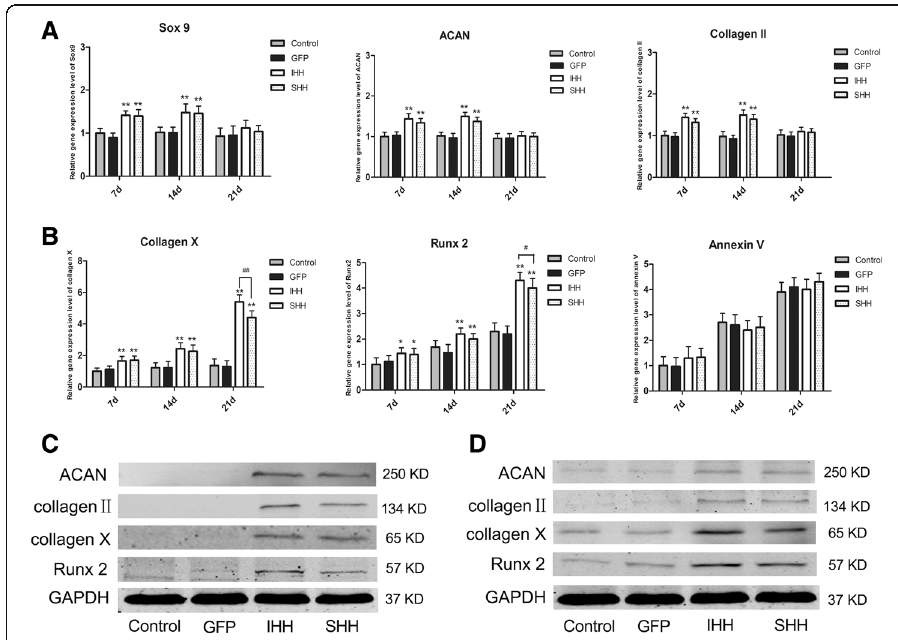
Fig. 3 Expression levels of related genes during differentiation induction in the 2D environment. ( a ) qRT- PCR analysis of Sox9, ACAN and collagen II on days 7, 14 and 21 during induction. ( b ) qRT-PCR analysis of collagen X, Runx2 and annexin V on days 7, 14 and 21 during induction. The results were normalized to B2M mRNA expression. Values are means ± SD (n = 3). ( c ) Expression of ACAN, collagen II, collagen X and Runx2 was detected by western blotting on day 10 during induction. ( d ) Expression of ACAN, collagen II, collagen X and Runx2 was detected by western blotting on day 21 during induction. Significant differences from the control group (non-transfection cells) are indicated by * p < 0.05 or ** p < 0.01; differences between IHH and SHH transfection groups are indicated by # p < 0.05 or ## p <